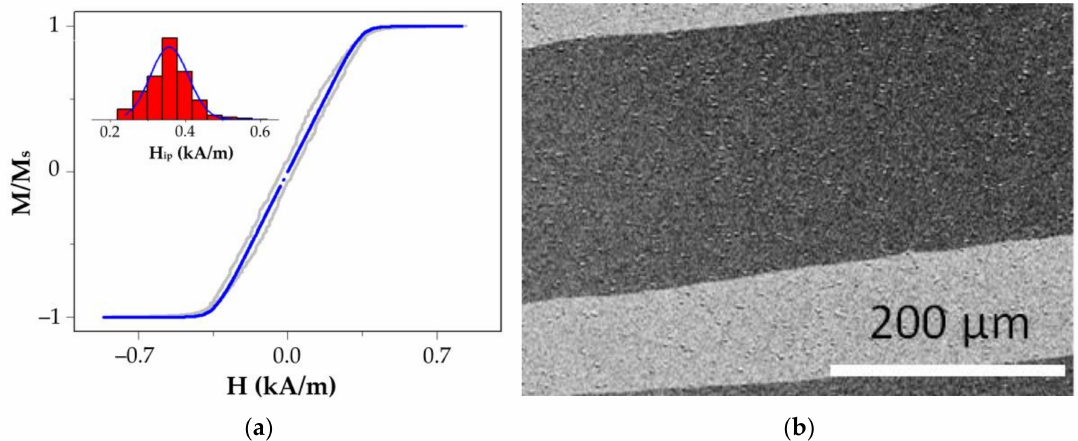
Figure 2. The magnetization curve of the Py (100 nm) film in the in-plane applied magnetic field perpendicular to the in-plane easy magnetization axis (gray symbols) and its fitting using Formula (1) (the inset shows the evaluation result for the film Py (100 nm)) ( a ). The magnetic domain structure in the zero magnetic field; the easy magnetization axis is oriented close to the horizontal direction ( b